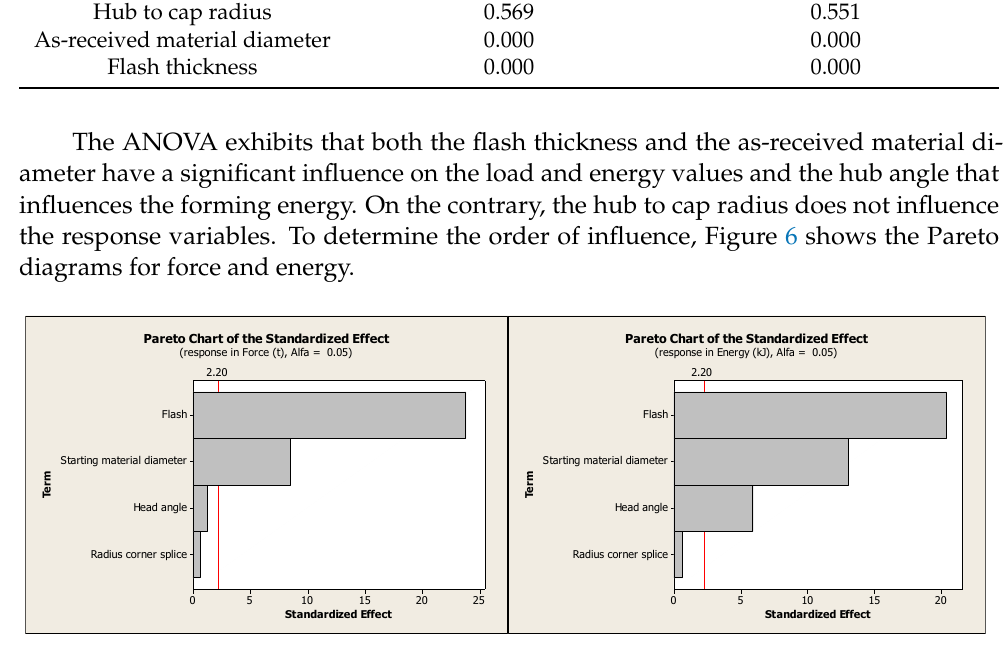
Figure 7. Sequence of fold formation at the cap of the head of the screw spike. Several samples of screws spikes were analyzed with penetrant inks to validate the computational simulations. Figure 8 demonstrates the result of the penetrant inks show- ing the circular-shaped fold on the cap of the screw. Figure 8. Folds exposed by penetrating inks on the cap of the screw.